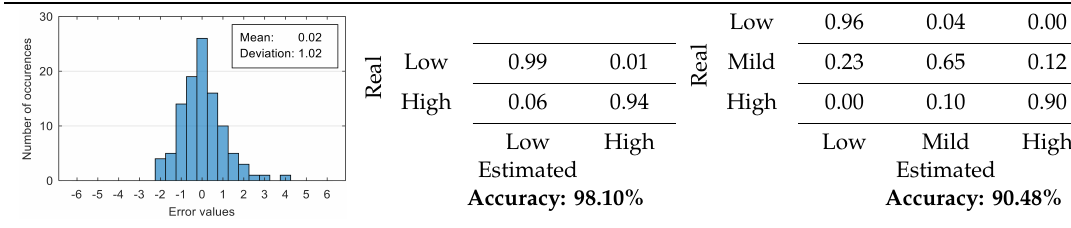
Table 12. Distribution of estimation errors and confusion matrices for levels 2 and 3—using seven